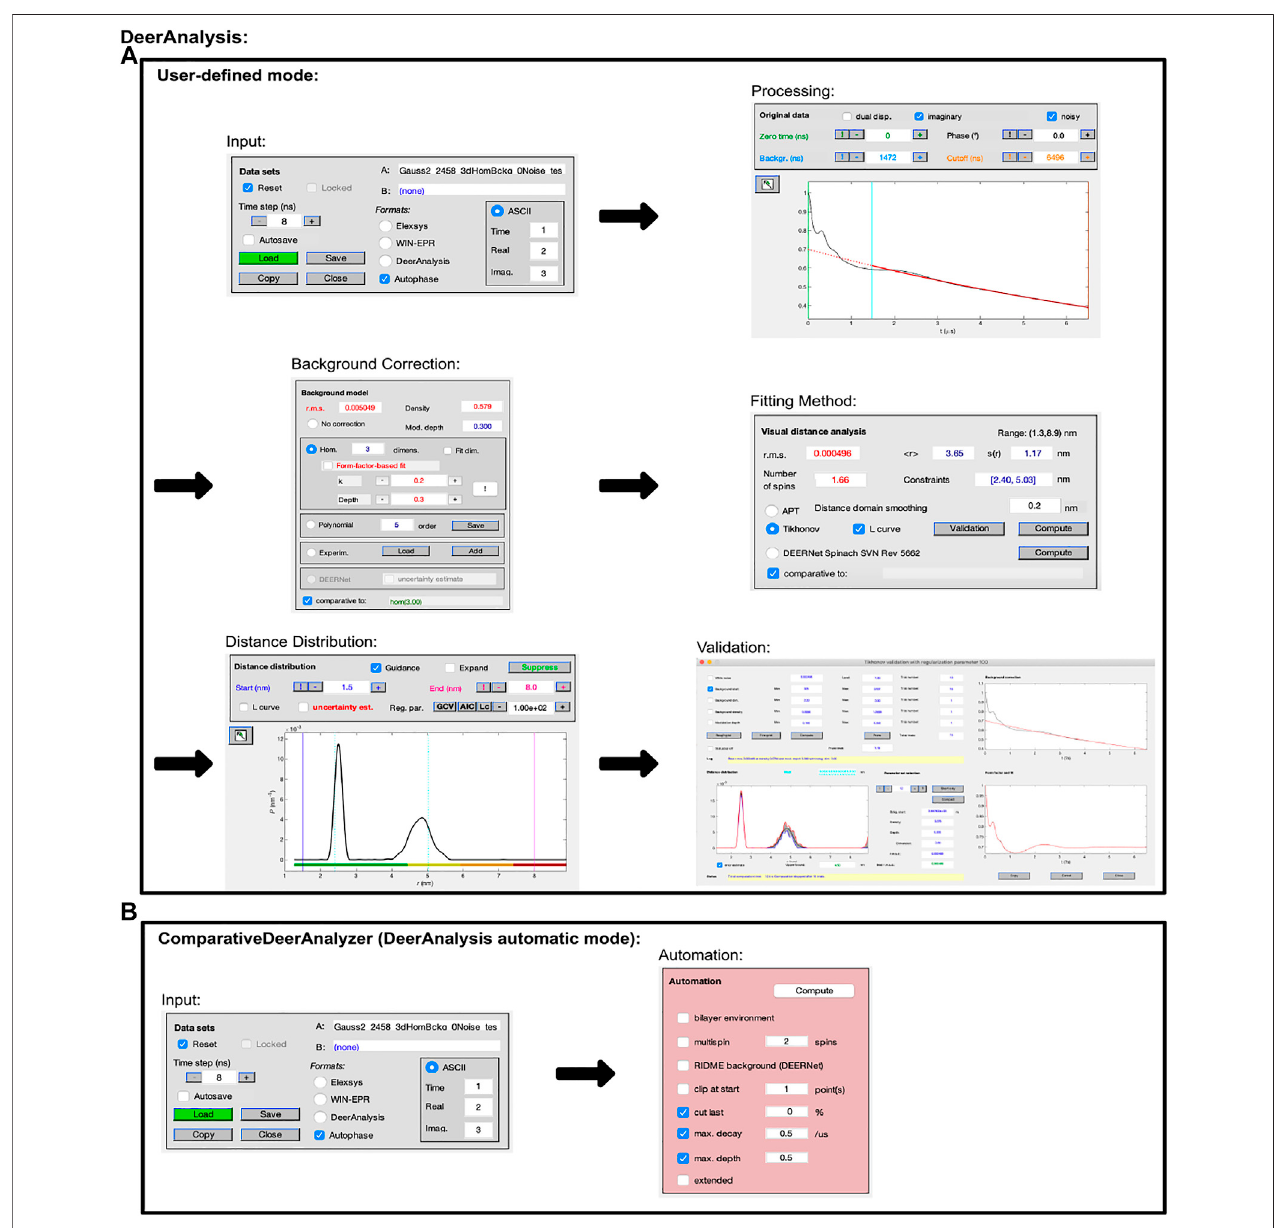
FIGURE 1 | DeerAnalysis2022 work fl ow. The program is Matlab-based and available on all operating systems. Data set shown is simulated noiseless, which was an ASCII fi le. For users using Elexsys fi le types, “ Elexsys ” should be selected in place of “ ASCII ” ; (A) “ user-de fi ned ” mode; (B) “ automation ” mode (otherwise known as ComparativeDeerAnalyzer, which is also available as a standalone Windows